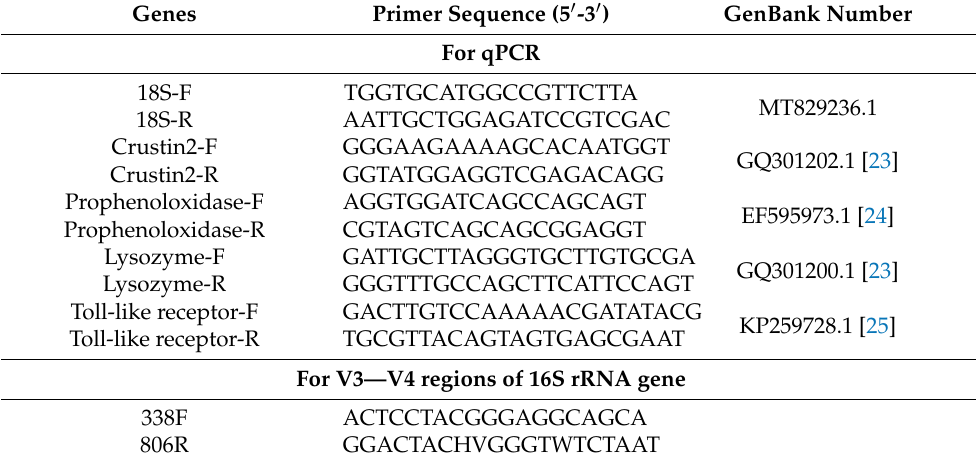
Table 1. List of primers used in this study. Genes Primer Sequence (5 (cid:48) -3 (cid:48)